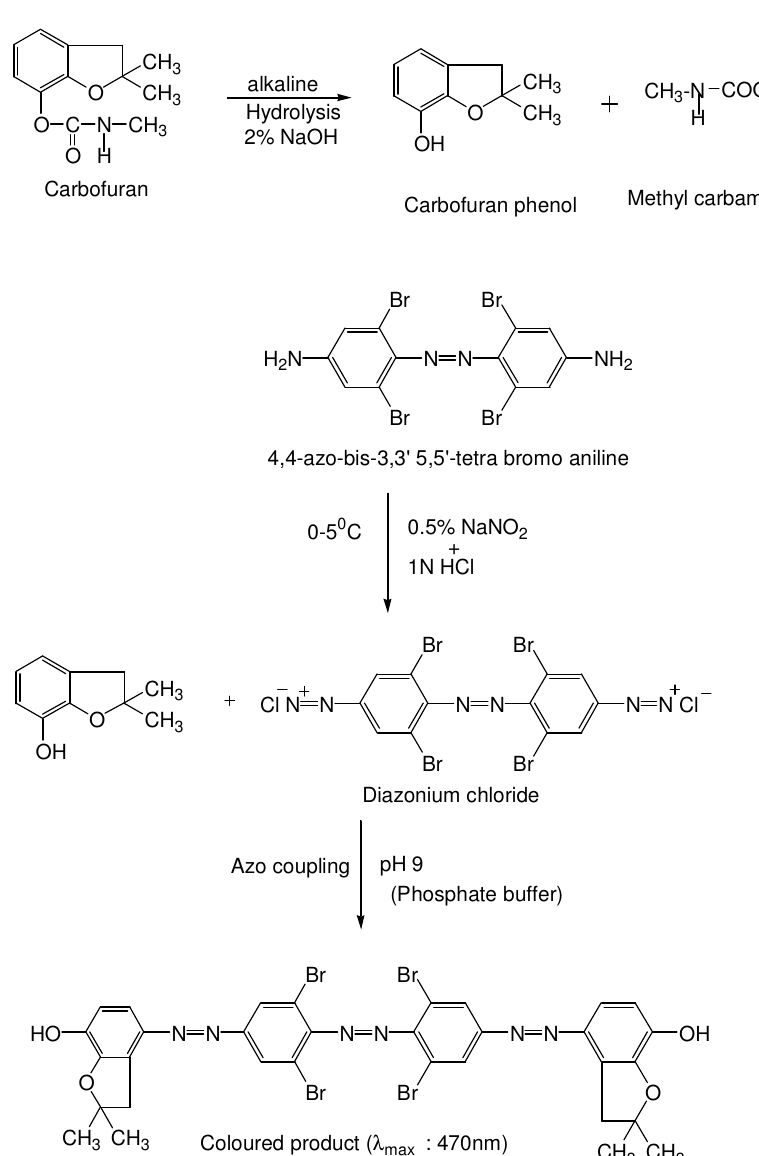
Scheme 2 Reaction mechanism of 4,4-azo-bis-3,3 ' 5,5'-tetrabromo aniline with